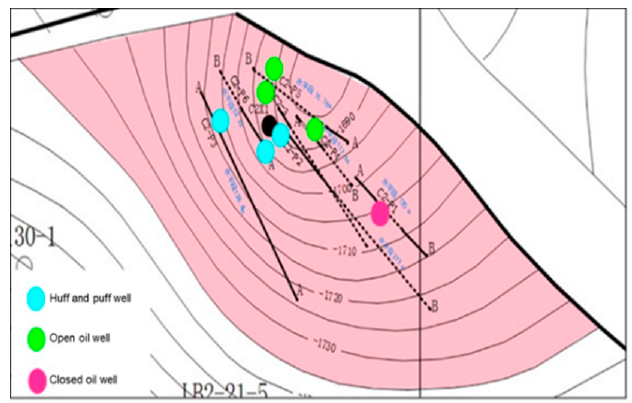
Figure 33. Structural well location map of C2X1. Table 10. Synergistic throughput implementation plan.